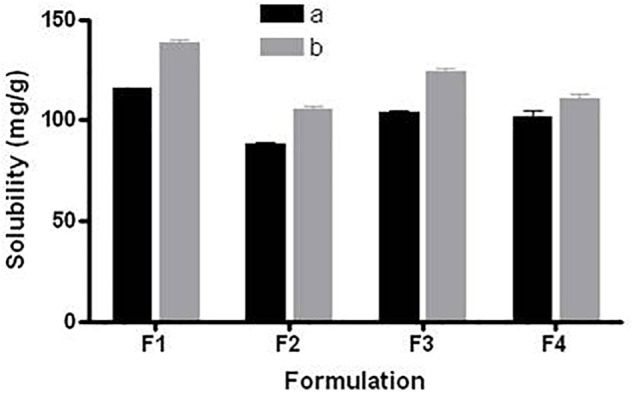
Equilibrium solubility of fenofibrate in group “a” and group “b” of LFCS formulations containing alternation lipid excipients. The formulation represent F1a- C70, F1b- K70, F2a- C70: CMCM (7:3)/TO106V (1/1), F2b- K70:I742(7:3)/TO106V(1/1), F3a- C70: CMCM (7:3)/HCO-30 (1/1), F3b- K70:I742(7:3)/HCO-30 (1/1), F4a- CMCM/HCO-30 (1/1) and F4b - I742/HCO-30 (1/1) respectively. Data are expressed as Mean ± SD, (n = 3).